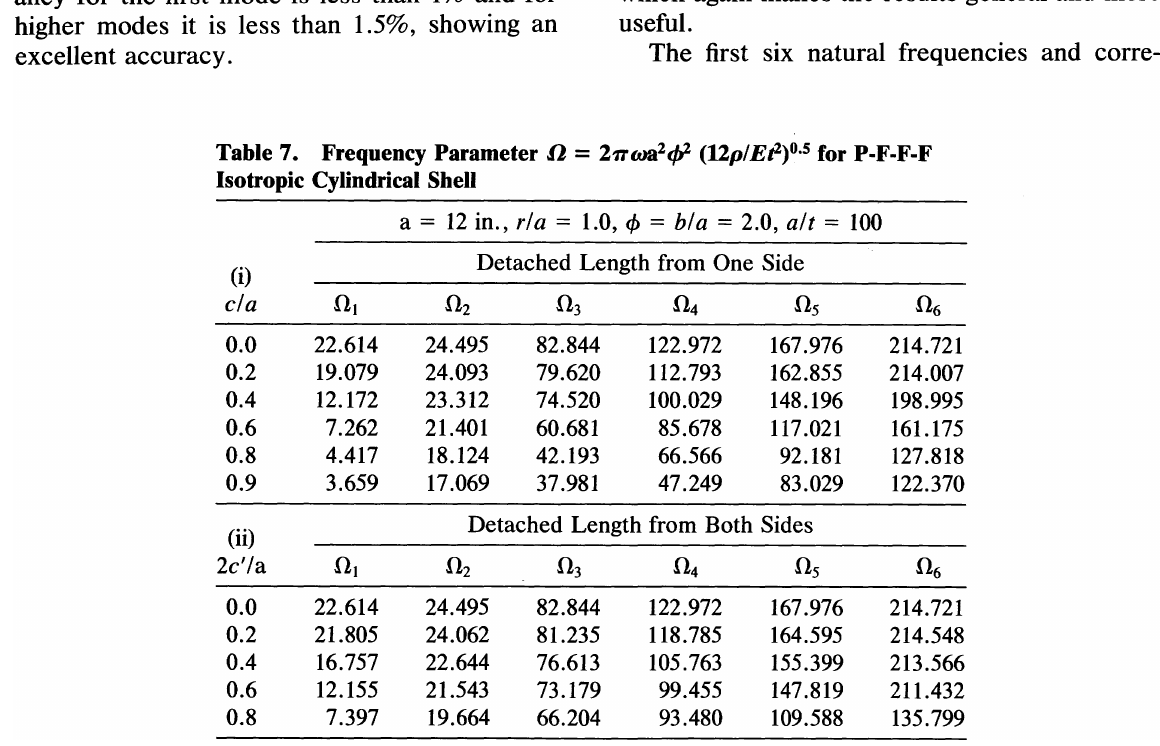
= 4Jl (12pIEP)o.s for P·F·F·F 2'1T6I8 z